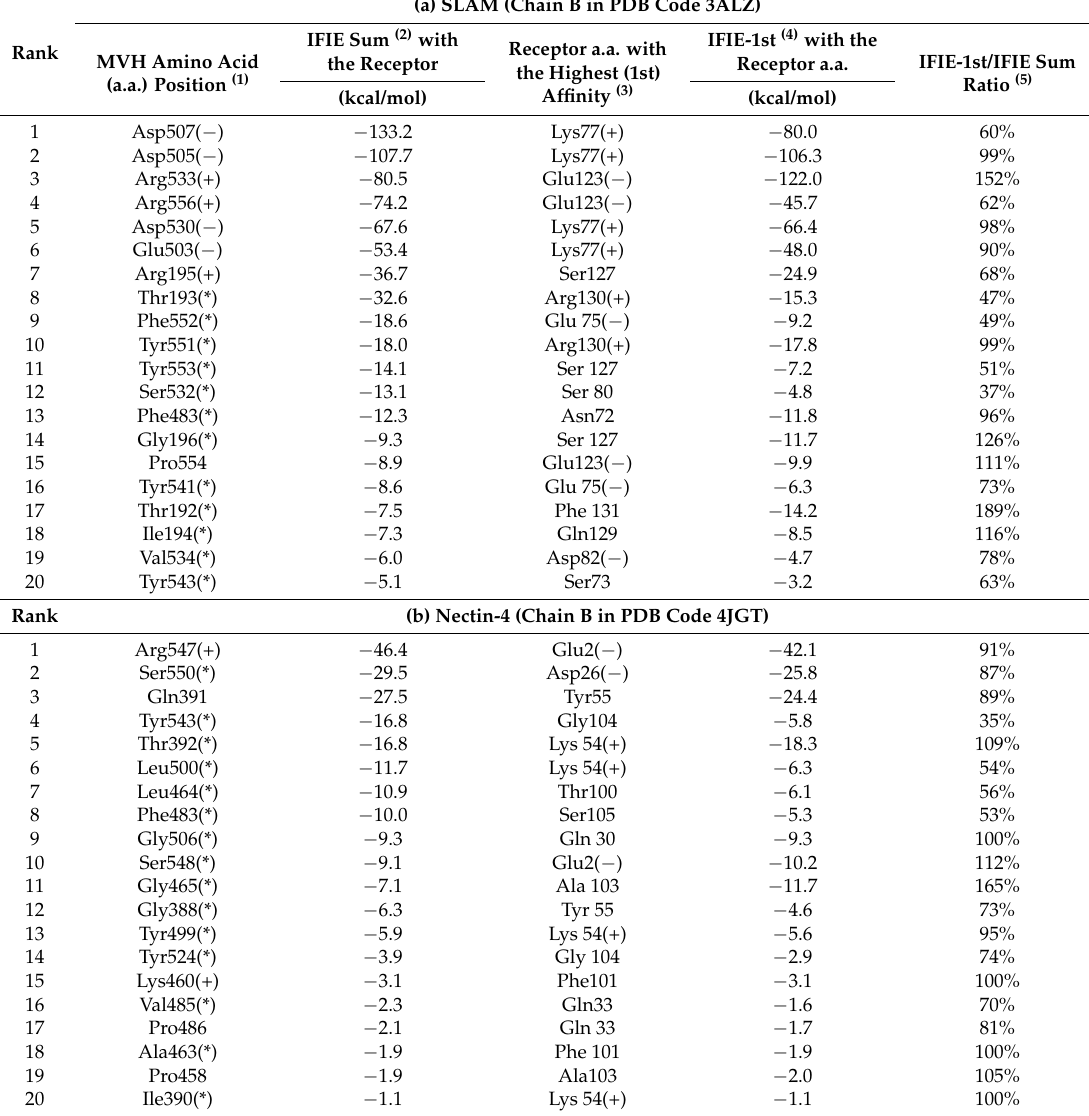
Table 2. Ranking of MVH residues showing strongly attractive interactions with the three